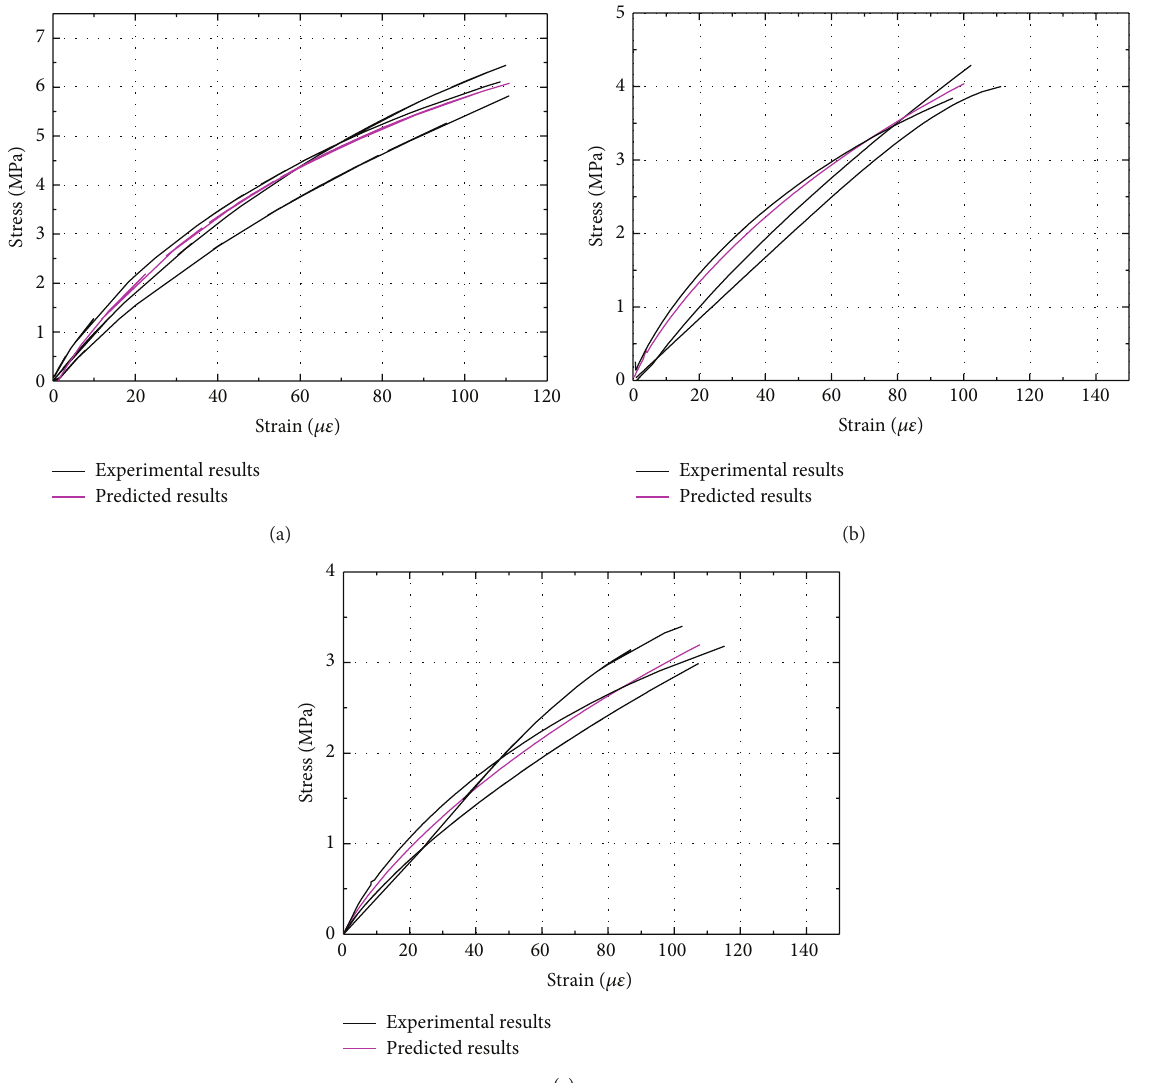
Figure 11: Comparison of predicted results with test data for cement mortar: (a) beam depth 40mm; (b) beam depth 100mm; (c) beam depth 150